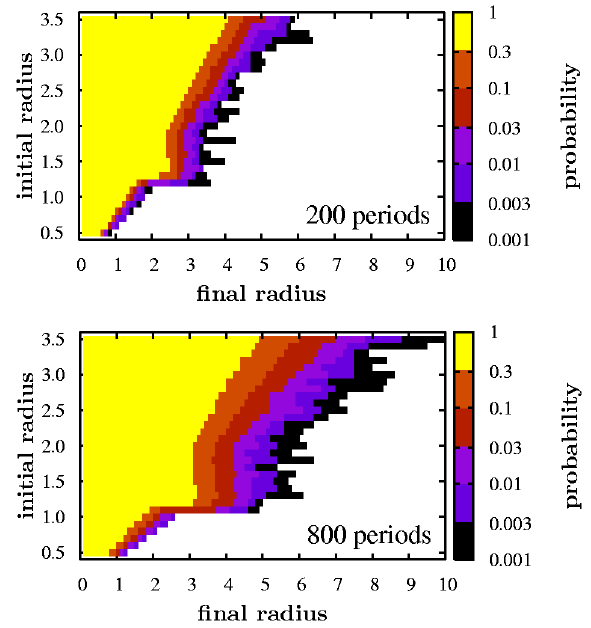
FIG. 11. (Color) Probability for single particles to reach final radii with large amplitudes; 200 and 800 zero-current betatron periods. The black bars represent one out of a total of 1000 simulations.